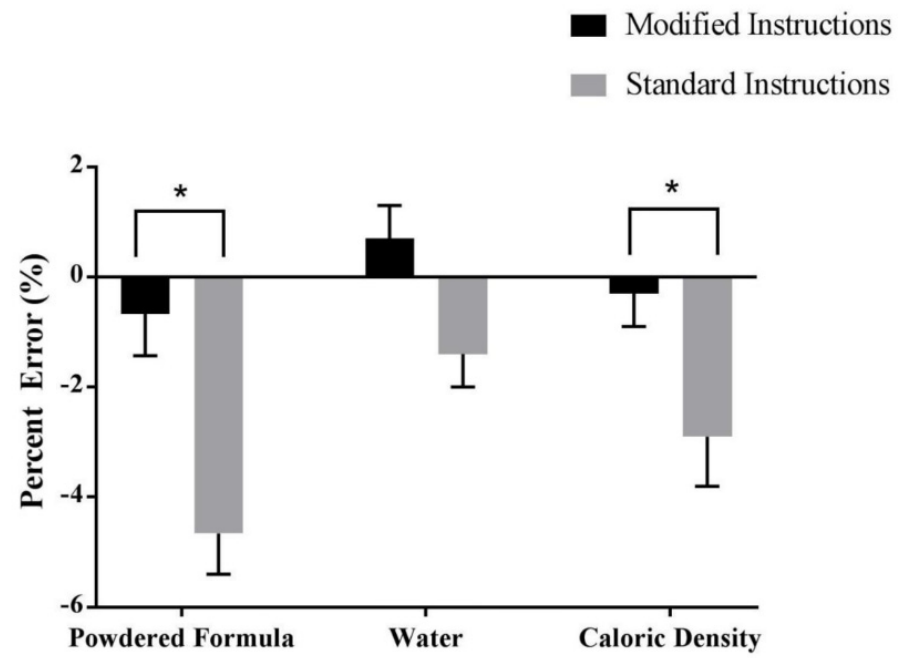
Figure 5. Percent Error of Powdered Formula Dispensing, Water Dispensing, and Caloric Density for the modified instructions group and the standard instructions group. Data are presented as the mean ± SD and * denotes significant ( p < 0.05) difference between groups. Black bars denote the modified instructions group and gray bars denote the standard instructions group.